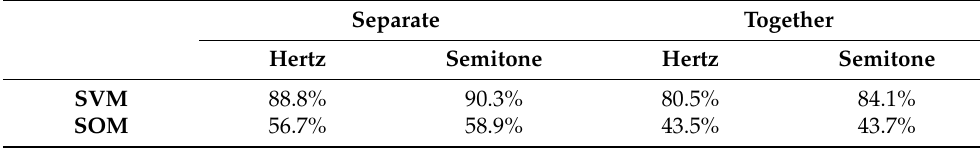
Table 5. Tone recognition rates using five-level abstraction based on SVM and SOM models. Separate Together Hertz Semitone Hertz Semitone SVM SOM